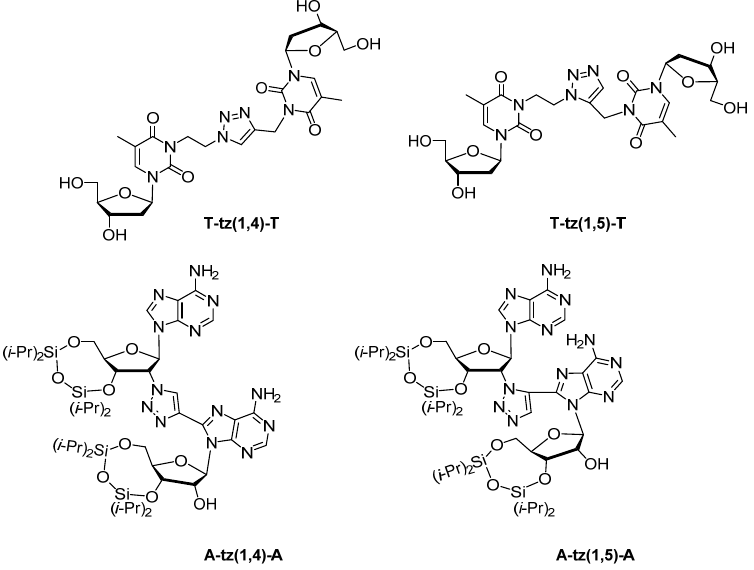
Figure 6. 1,4- and 1,5-bisnucleosides 1,2,3-triazole derivatives of thymidine and adenosine.